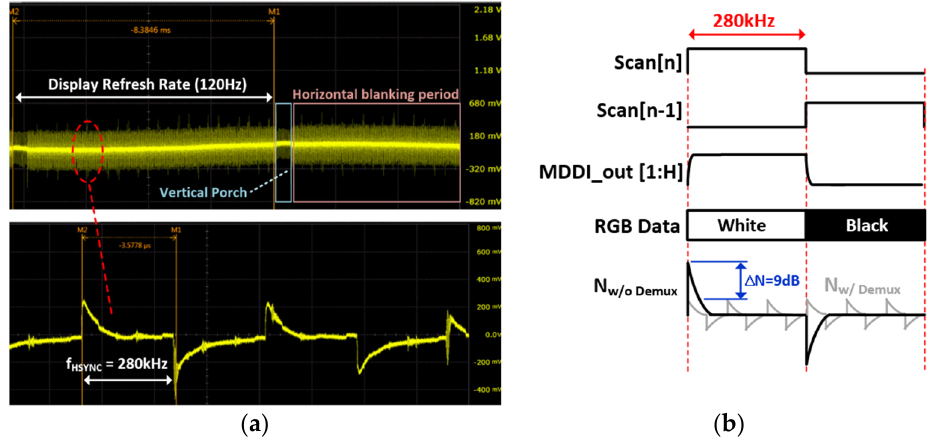
Figure 2. ( a ) Measured display noise with an FHD+ AMOLED display, and ( b ) comparison of display noise levels with a zebra image without Demux and with a 3-to-1 Demux configuration.